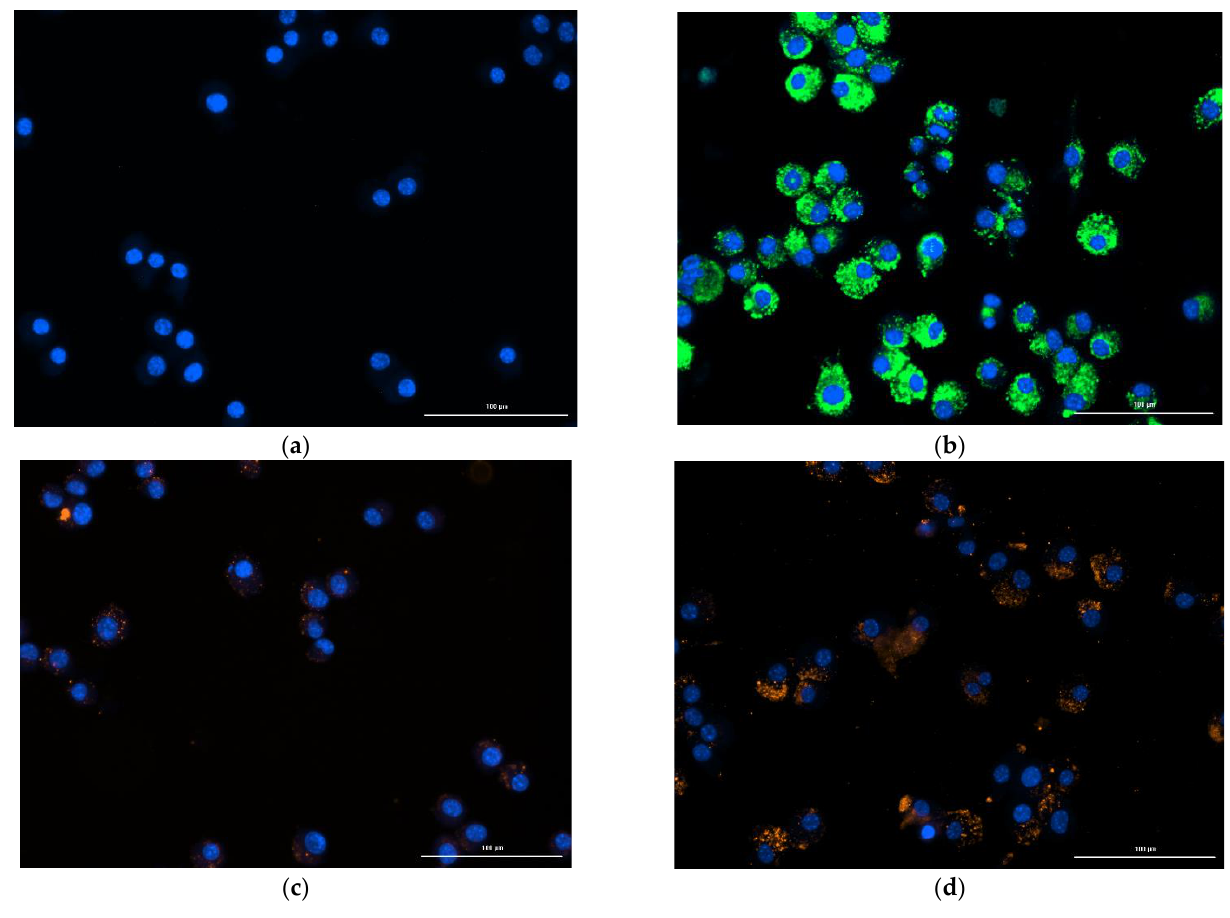
Figure 3. ( a ) J774.A1 control, without treatment; ( b ) J77A.A1 exposed to NLC with WGA with FITC. Ex:469; Em: 525; ( c ) J774.A1 exposed to NLC without surface functionalization with CN- PPV; ( d ) J774.A1 exposed to NLC-WGA with CN-PPV. Ex: 531; Em: